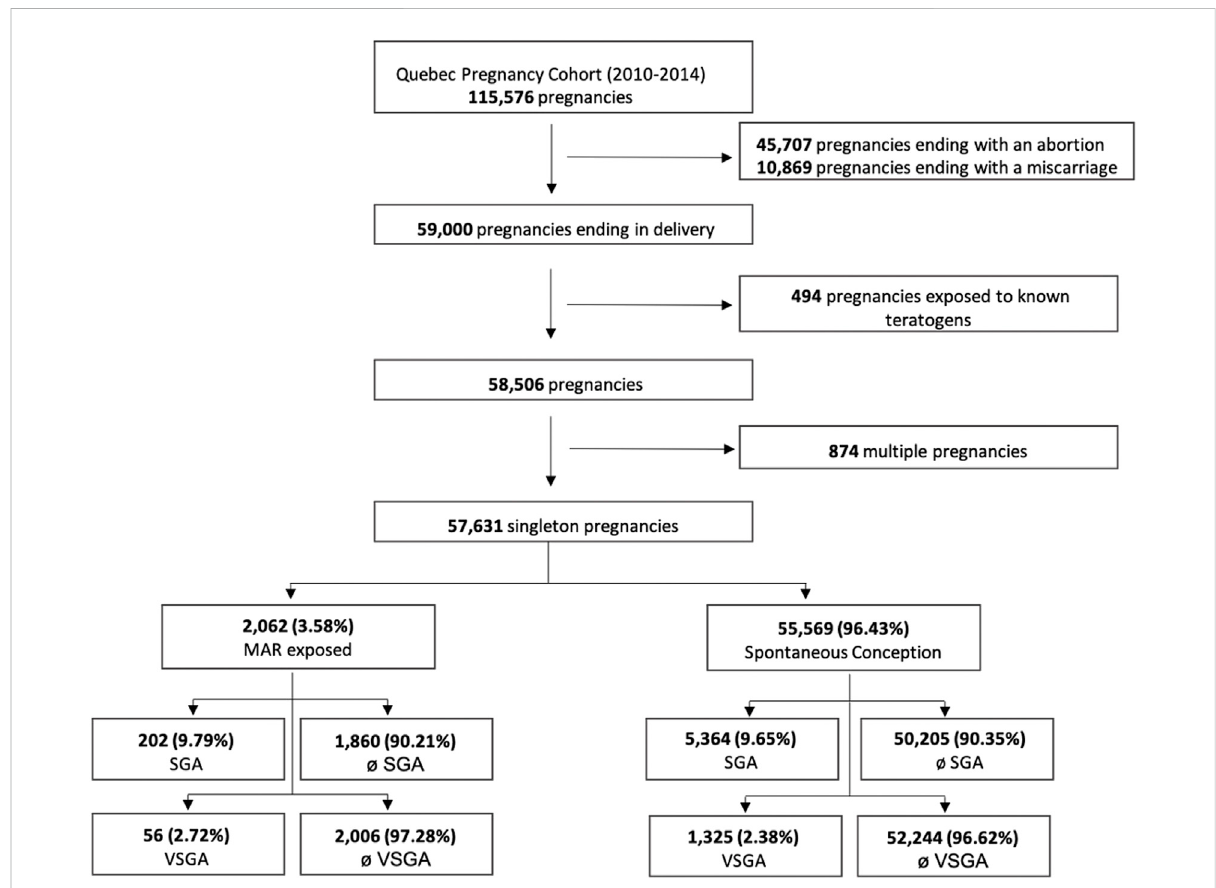
FIGURE 1 Flowchart of the selection process of the study population. MAR, medically assited reproduction; SGA, small for gestational age; VSGAI, very small for gestational age.